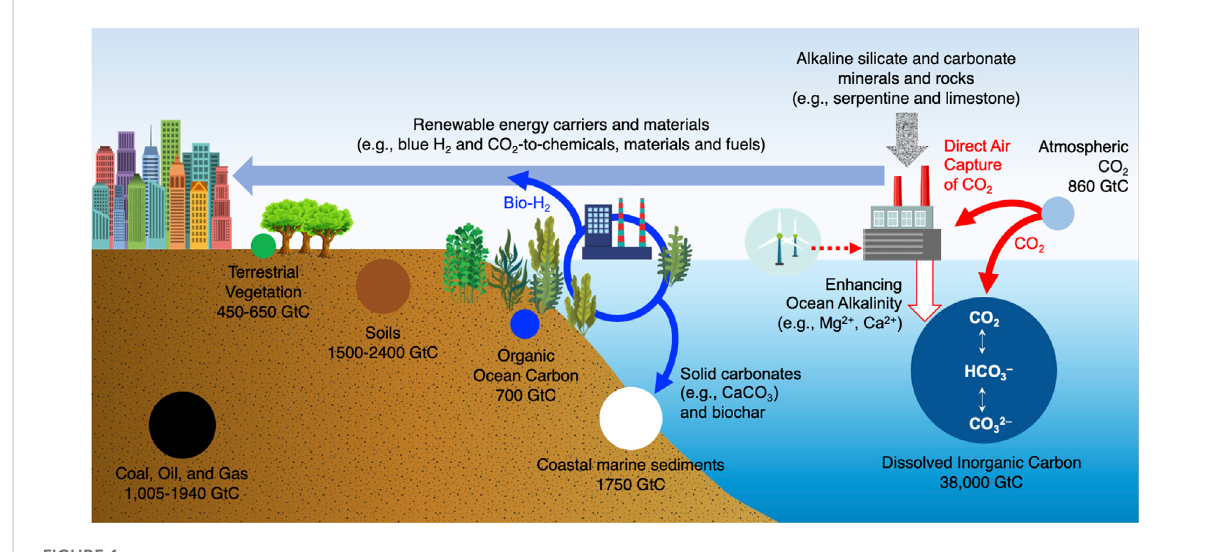
FIGURE 1 Distribution of carbon on Earth (data used from the Global Carbon Budget, 2020